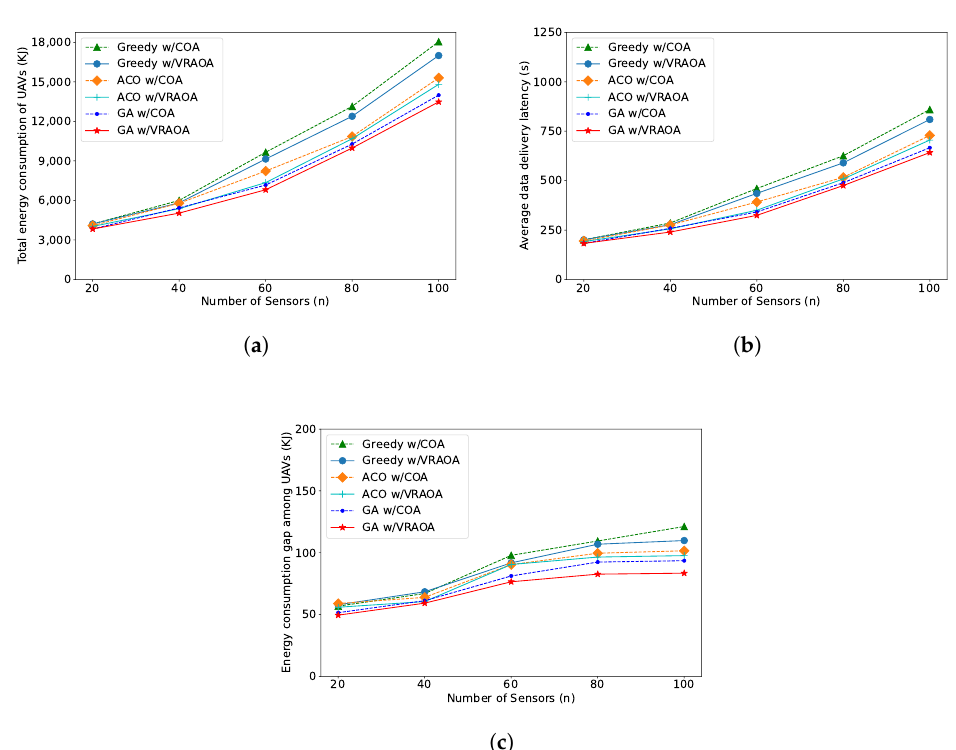
Figure 8. Effects of the number of sensors: ( a ) effect on the total energy consumption of UAVs, ( b ) effect on average data the delivery latency, and ( c ) effect on the energy consumption gap (standard deviation) among